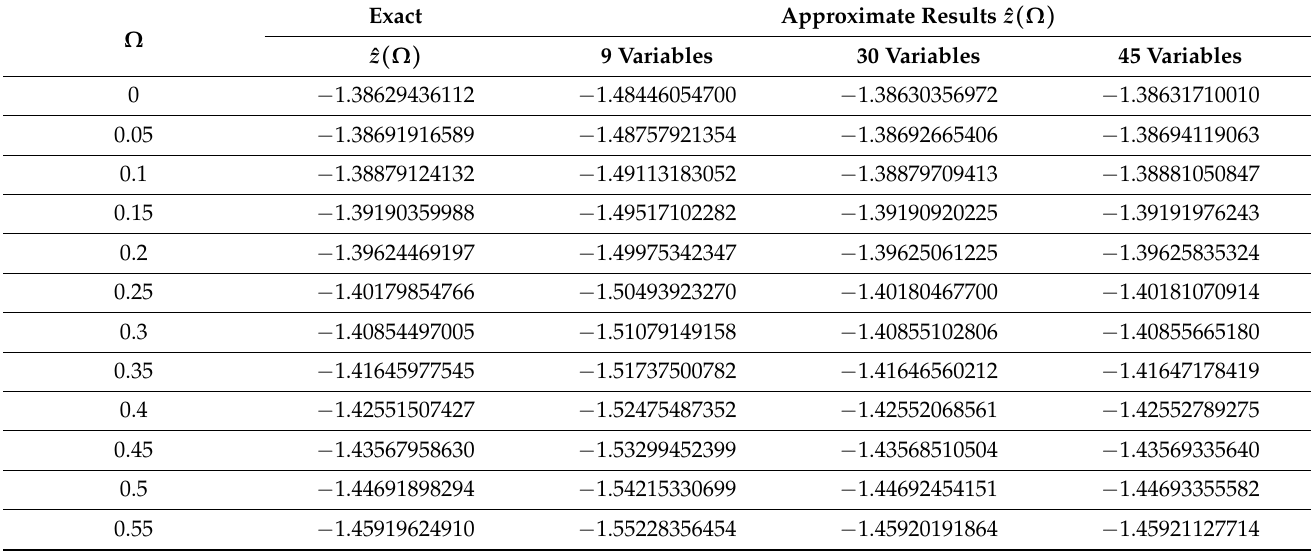
Table 4. Results comparison of Problem 3 using ANN-GA-SQPM based on three, 10, and 15 neurons or nine, 30, and 45 variables with the reference